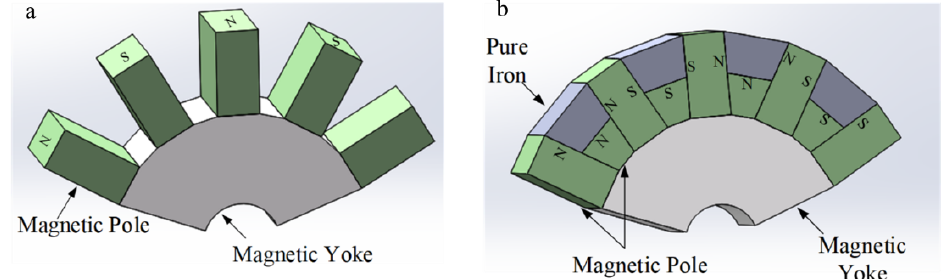
Figure 2. ( a ) Open magnetic system structure; ( b ) extruded magnetic system structure.